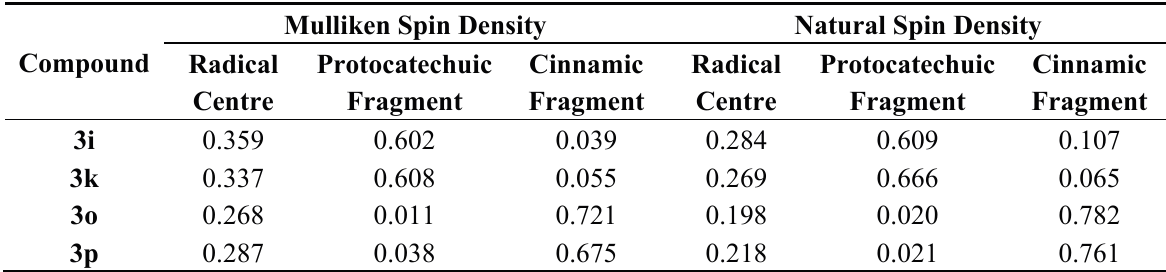
Table 3. Distribution of spin densities into radicals of compounds 3i , 3k , 3o and 3p .